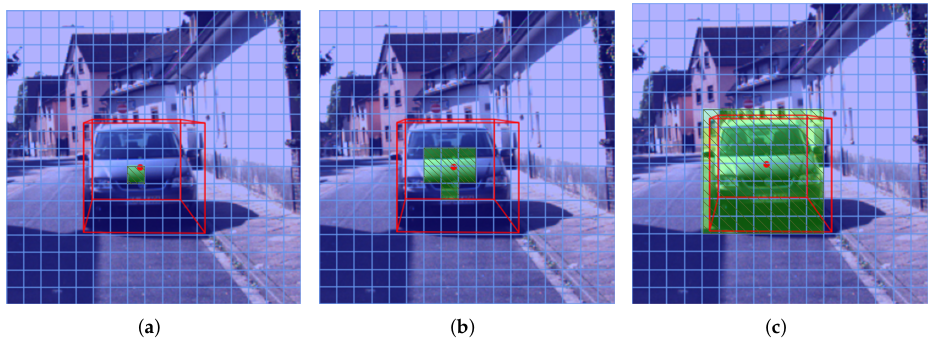
Figure 6. The comparison of positive samples’ assignment strategy among M3D-RPN ( a ), FCOS3D ( b ), and MDSNet ( c ). We use red box to denote the ground truth box, light blue grid to denote negative samples, and light green masked grid to denote positive